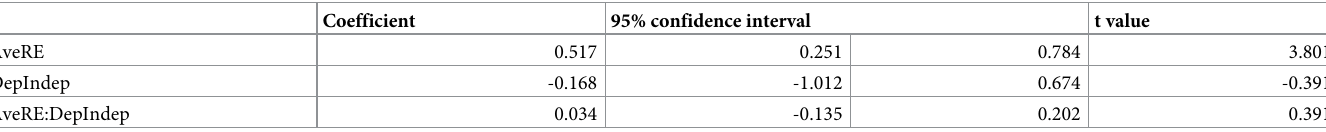
Table 2. Output of ordinal regression Model 1. AveRE: the average scores for all the RV statements. DepIndep: the respondent’s assigned